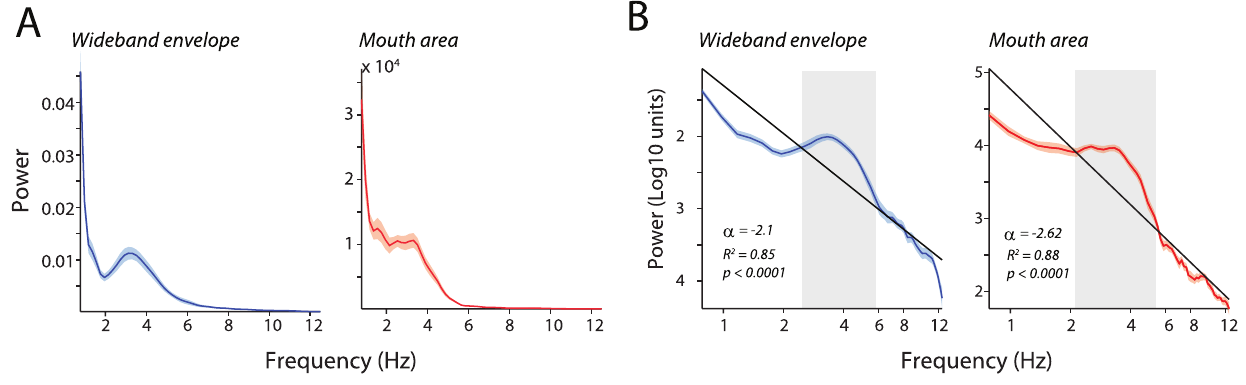
Figure 5. Temporal modulations in the visual and auditory signals. A - Left, average multitaper Fourier spectrum of the wideband auditory envelope across all sentences for a single subject from the GRID corpus. X-axes depicts frequency in Hz. Y-axes depicts power. Shaded regions denote the standard error of the mean. Note the peak between 2–7 Hz. Right, average multitaper Fourier spectrum of the mouth area function across all the sentences for the same subject shown in the left panel. X-axes depicts frequency in Hz. Y-axes depicts power. Shaded regions denote the standard error of the mean. B - Left, average multitaper Fourier spectrum of the wideband auditory envelope across all sentences for the same subject shown in A plotted on log-log axes. X-axes depicts frequency in Hz. Y-axes depicts power in log10 units. Shaded regions denote the standard error of the mean. Black line denotes a 1/f fit to the data. Deviations from 1/f are usually observed when there are rhythmic modulations in a signal. Right, average multitaper Fourier spectrum of the mouth area function across all the sentences for the same subject. Figure conventions as in the left